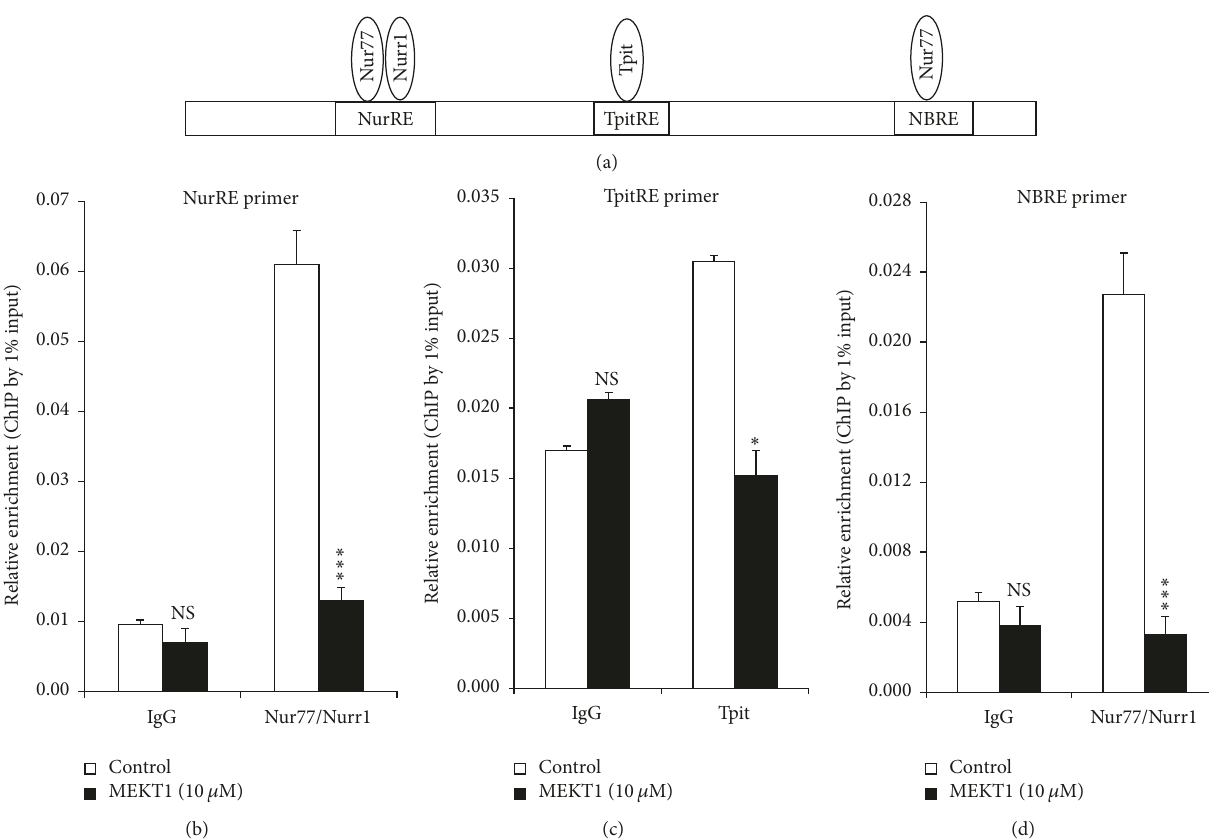
Figure 10: Effects of MEKT1 on the interaction between Nur77/Nurr1 and NurRE, Tpit and TpitRE, and Nur77 and NBRE on Pomc promoter (a) in AtT20 cells. Effects of MEKT1 on the interaction between Nur77/Nurr1 and NurRE (b), Tpit and TpitRE (c), and Nur77 and NBRE (d) on Pomc promoter examined by ChIP assay using NurRE, TpitRE, and NBRE primer. ChIP assay was carried out using digested chromatin extracted from the cells cultured in the presence of either 10 𝜇 M MEKT1 or 0.1% DMSO (control) for 24 hours. Chromatin fragments were immunoprecipitated either by normal rabbit IgG (negative control), anti-Nur77/Nurr1 antibody, or anti-Tpit (anti TBX 19) antibody. Purified DNAwasanalyzedbyqPCRusingprimersspecificforNurRE,TpitRE,andNBREcontainingsequenceon Pomc promoter.Theprimerproduct sizes of NurRE, TpitRE, and NBRE were 211bp, 146bp, and 102bp, respectively. Immunoprecipitated DNA was amplified by qPCR and then normalized to the values obtained after amplification of immunoprecipitated 1% input DNA. Data represent mean ± SEM ( 𝑛 = 3 ). NS means “not significant.” ∗ 𝑃 < 0.05 , and ∗∗∗ 𝑃 < 0.001 significantly different from the level of control